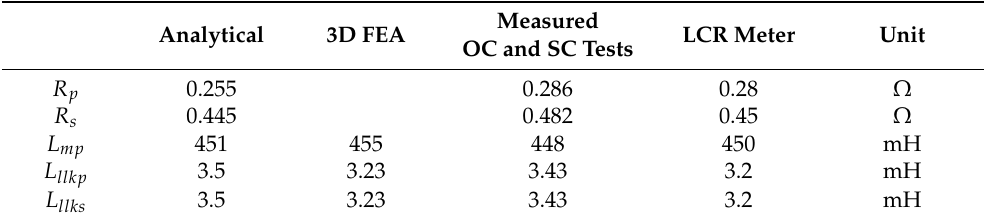
Table 5. Inductance and resistance measurements per phase for the 0.6 mm air-gap rotary transformer at 25